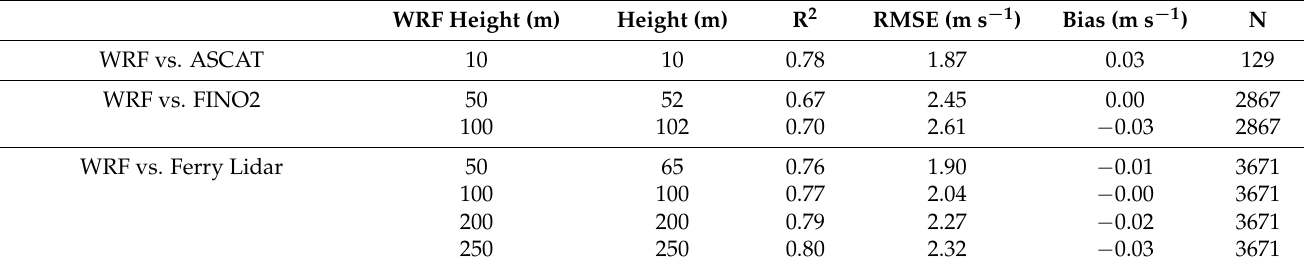
Table 5. RMSE results of the NEWA WRF data compared to the other data sources for the wind speed. WRF Height (m) Height (m) R 2 RMSE (m s − 1 ) Bias (m s − 1 ) N WRF vs. ASCAT WRF vs. FINO2 WRF vs. Ferry Lidar